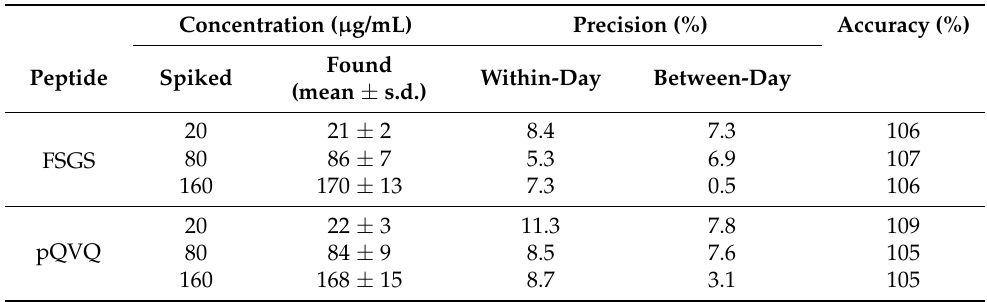
Table 5. Assessment of accuracy and precision for rituximab in plasma using the LC-MS/HRMS method and FSGS or pQVQ as surrogate peptides ( n = 6, five days). Concentration ( µ g/mL) Precision (%) Accuracy (%) Found Peptide Spiked